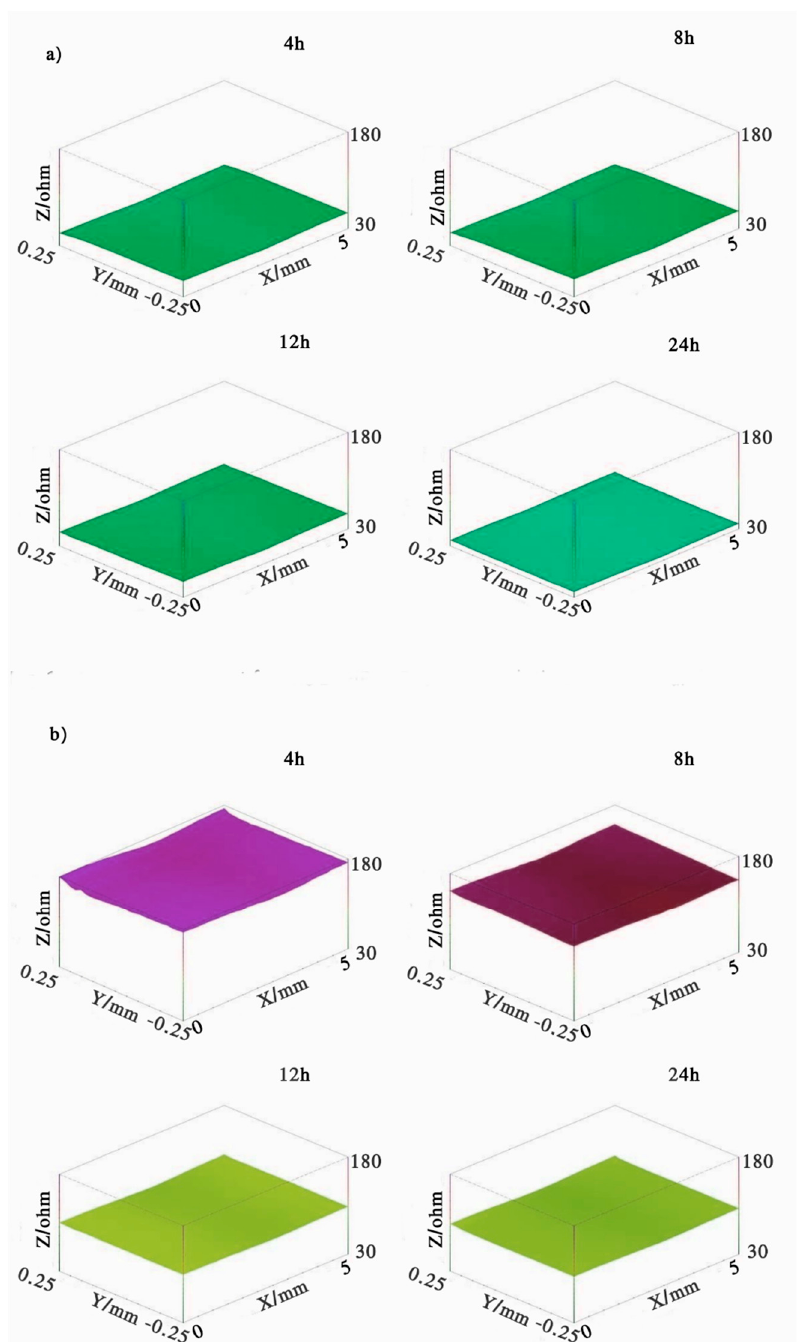
Figure 16 . Local electrochemical impedance maps (LEIM) obtained for samples 212 ( a ) and 21PIP ( b ). Frequency: 5000 Hz. Immersion time: 4, 8, 12 and 24 h. Electrolyte: 0.001 M NaCl aqueous solution.